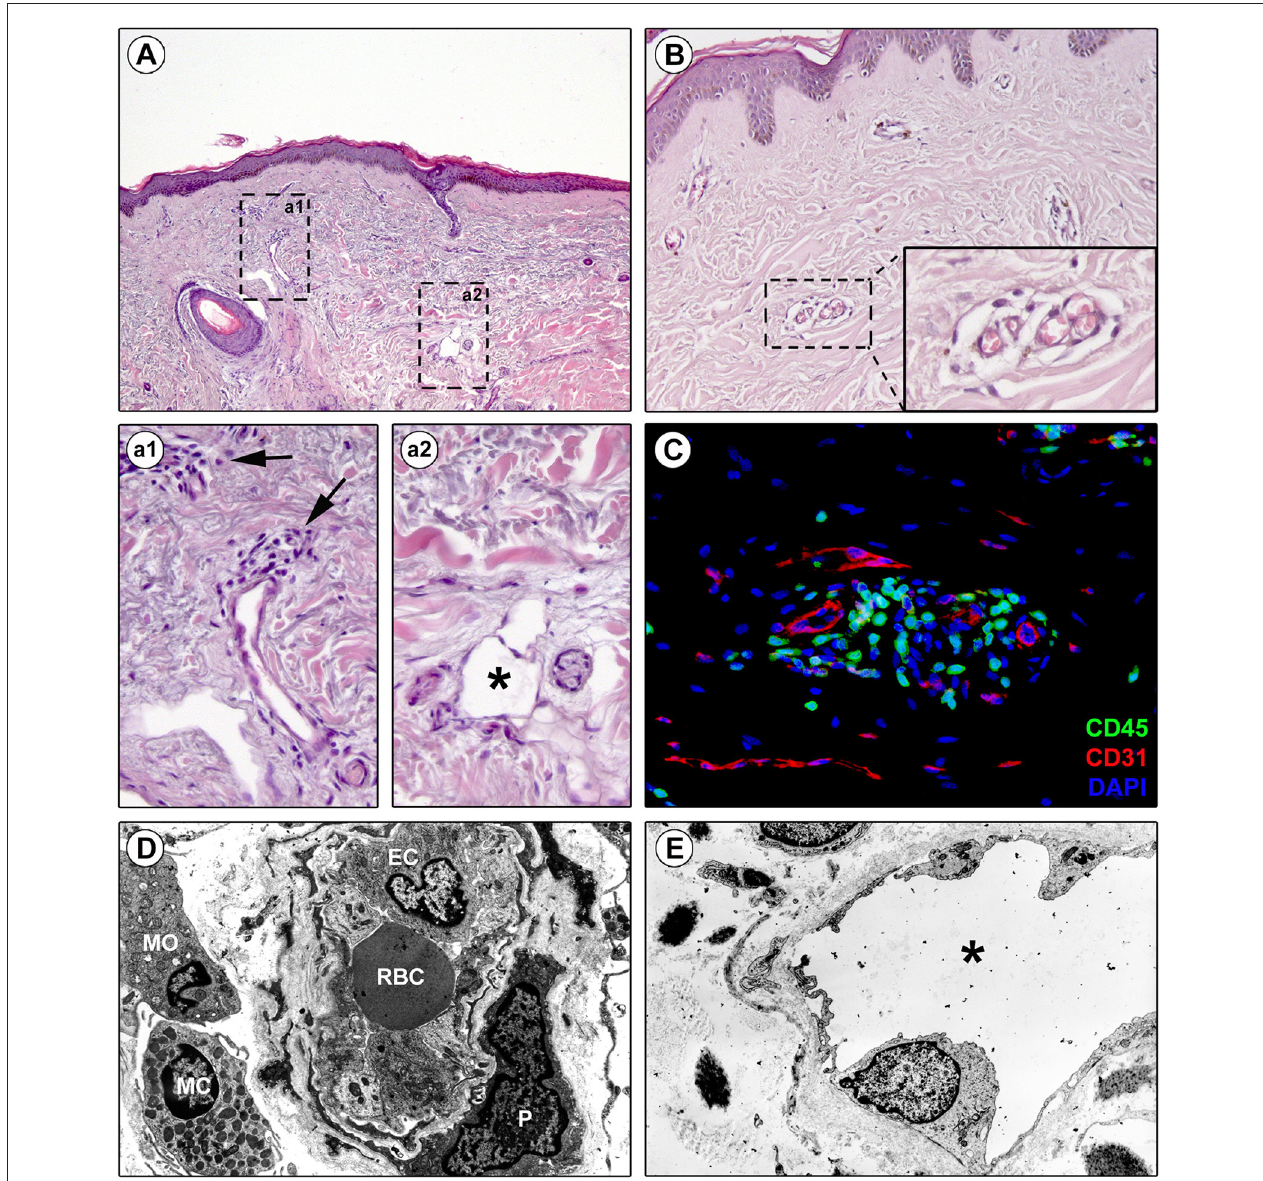
FIGURE 1 | Perivascular edema and inflammatory cell infiltration are prominent in skin of early diffuse cutaneous systemic sclerosis (SSc). Representative microphotographs of paraffin-embedded skin sections from patients with early diffuse cutaneous SSc subjected to hematoxylin and eosin staining (A, a1, a2, B) or double immunofluorescence staining for CD45/leukocyte common antigen (green) and CD31/pan-endothelial cell marker (red) with 4 ′ ,6-diamidino-2-phenylindole (DAPI, blue) counterstain for nuclei (C) are shown. (a1) and (a2) represent higher magnifications of the boxed areas in (A) . (a1) Infiltrating inflammatory cells are observed around small dermal blood vessels (arrows). (a2) A dermal lymphatic vessel with an enlarged lumen (asterisk) is surrounded by edematous extracellular matrix. (B) Edema is prominent around blood capillaries. The inset depicts a higher magnification view of the boxed area from the respective panel. (C) CD45-positive inflammatory cells are widely found in the perivascular area. (D,E) Representative transmission electron microscopy microphotographs of ultrathin skin sections from patients with early diffuse cutaneous SSc. (D) A blood capillary displays hypertrophic endothelial cells and is surrounded by edema and inflammatory cells. (E) A lymphatic vessel surrounded by edema shows an enlarged lumen (asterisk). EC, endothelial cell; MC, mast cell; MO, mononuclear cell; P, pericyte; RBC, red blood cell.